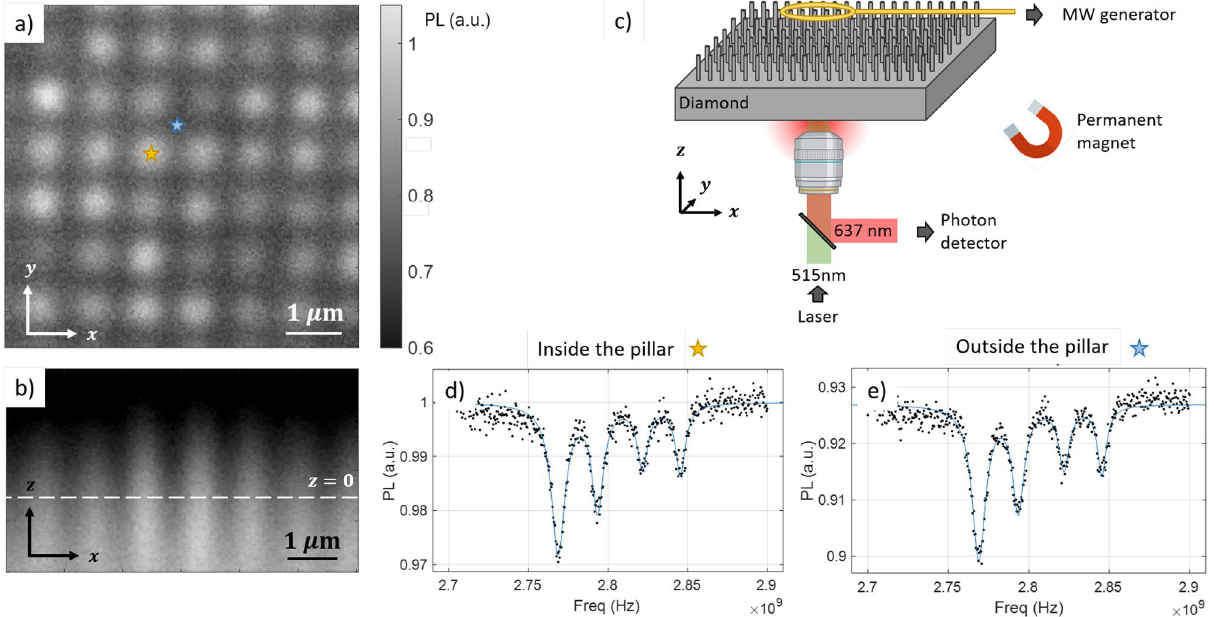
Figure 3. ( a ) Photoluminescence xy -map at the diamond surface level ( z = 0 ). The pillars ( d = 500 nm and p = 1 µ m) can be clearly distinguished as brighter spots. ( b ) Photoluminescence xz -map, demonstrating the pillar waveguiding effect. The dashed line represents the estimated surface level. ( c ) Schematic of the experimental configuration used for both PL and ODMR measurements. Figure not on scale. MW = Microwave. ( d ) Continuous-wave ODMR spectrum acquired from one pillar, in presence of a magnetic field (few mT). For better visibility only the lower half of the spectrum is reported. The other four resonances are symmetric with respect to the zero-field resonance at 2.87 GHz. ( e ) Continuous-wave ODMR spectrum acquired in between pillars, in the same experimental conditions as for the spectrum in ( d ). All the plots are normalized to the largest PL signal level measured on this